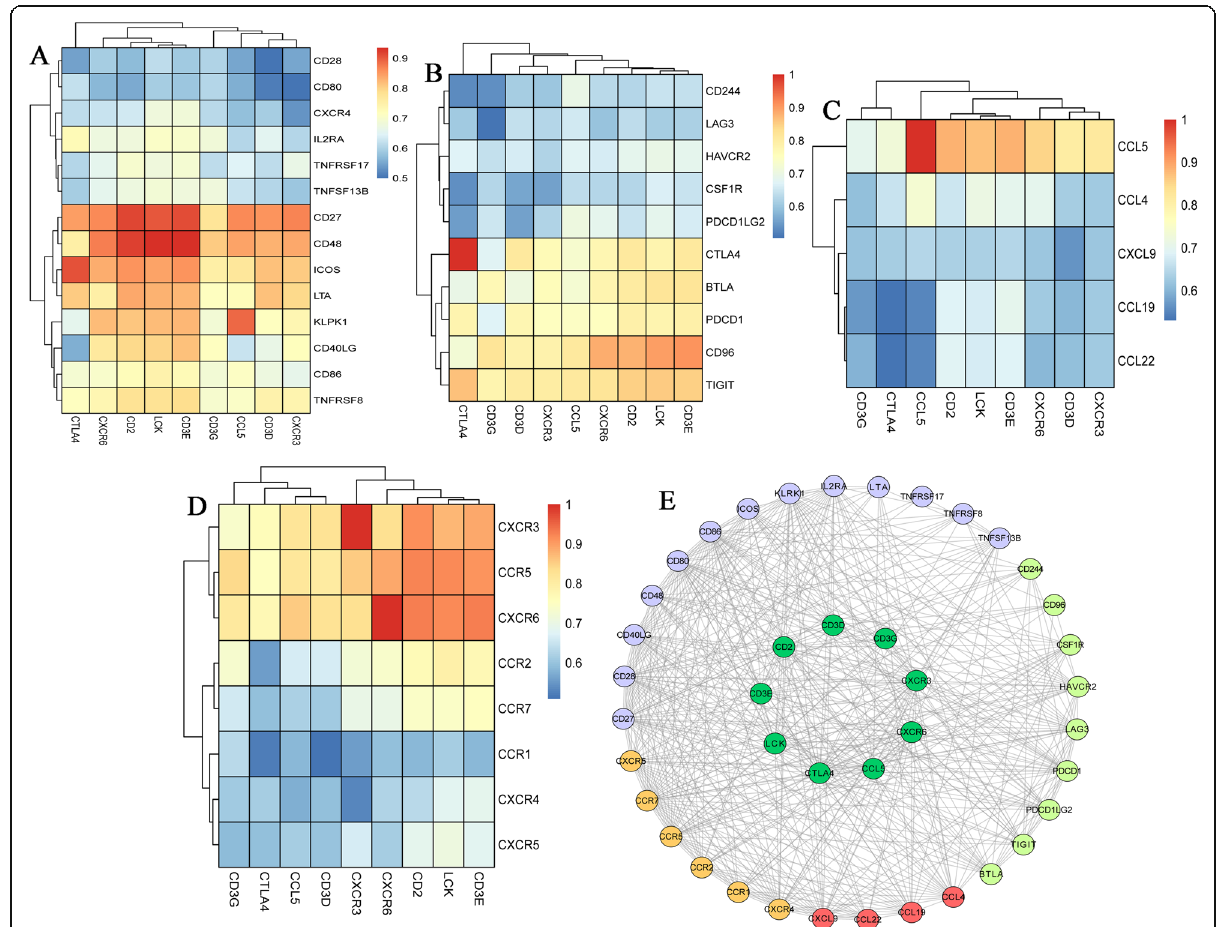
Fig. 6 Association between 9 hub genes and immune factors. A Heatmap of association between 9 hub genes and immune stimulating factors. B Heatmap of association between 9 hub genes and immunosuppressive factors. C Heatmap of association between 9 hub genes and chemokines. D Heatmap of association between 9 hub genes and receptors. E Protein-protein interaction (PPI) network of 9 hub genes and immune factors. The average correlation between 32 immune-related factors and 9 hub genes was >